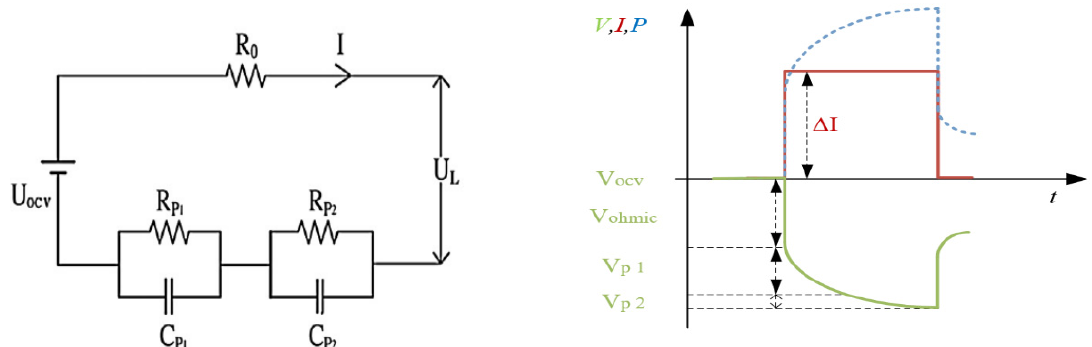
Figure 3. The corresponding region of the pulse and the schematics of the electrical